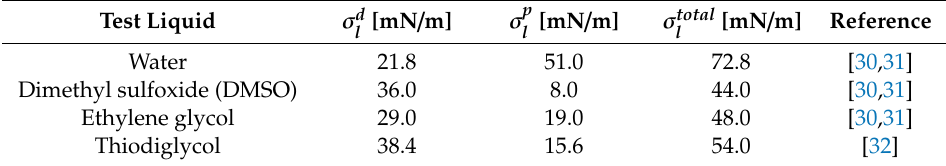
Table 1. Test Liquids and Corresponding Surface Tension